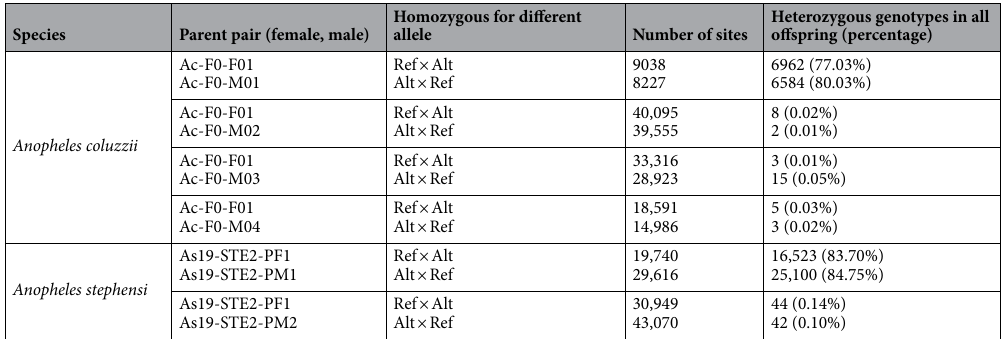
Table 2. Mendelian inheritance for male parent identification. The Mendelian inheritance-based approach for paternity analysis reveals the number of sites at which all offspring are heterozygous for different pairs of parents where parents are homozygous for different alleles.